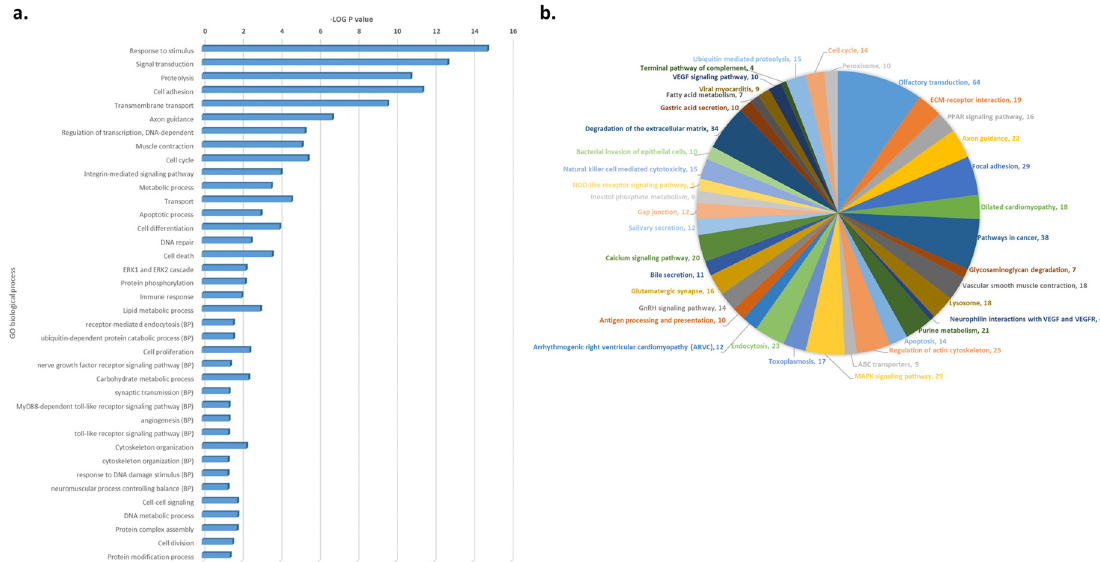
Figure 2. Functional enrichment analysis of the SNP mutant genes identified in the ALS patient by WES. The most representative ( a ) GO and ( b ) pathways terms that exhibit statistically significant di ff erences are shown in the graphic (Fisher’s exact test, FDR; p <